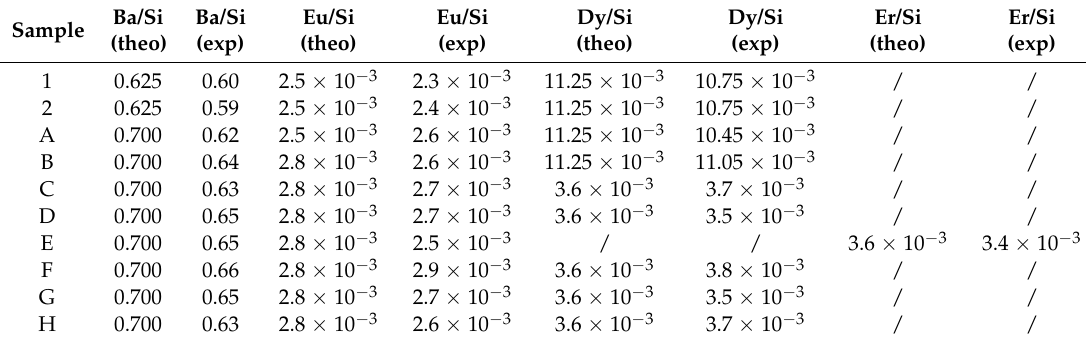
Table 4. Theoretical (theo) and experimental (exp) molar ratios for phosphors from elemental analysis.